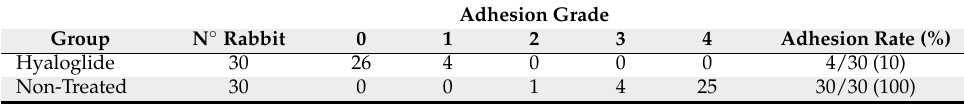
Table 2. Post-operative adhesion rates and grades for two groups.